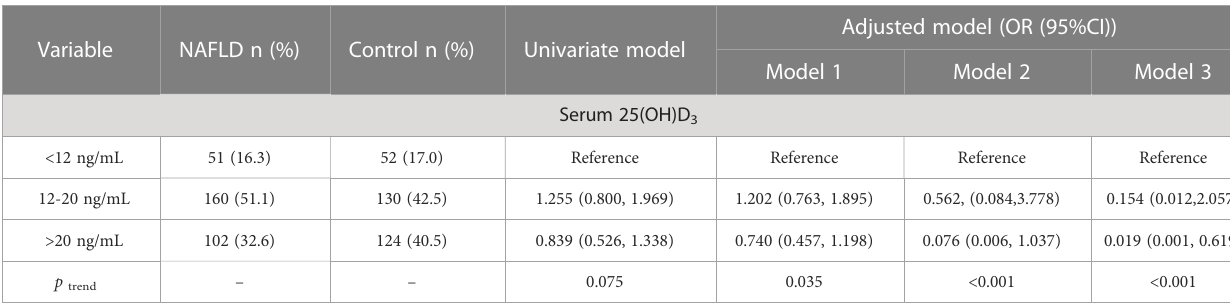
TABLE 5 Association between serum 25(OH)D 3 levels and NAFLD.